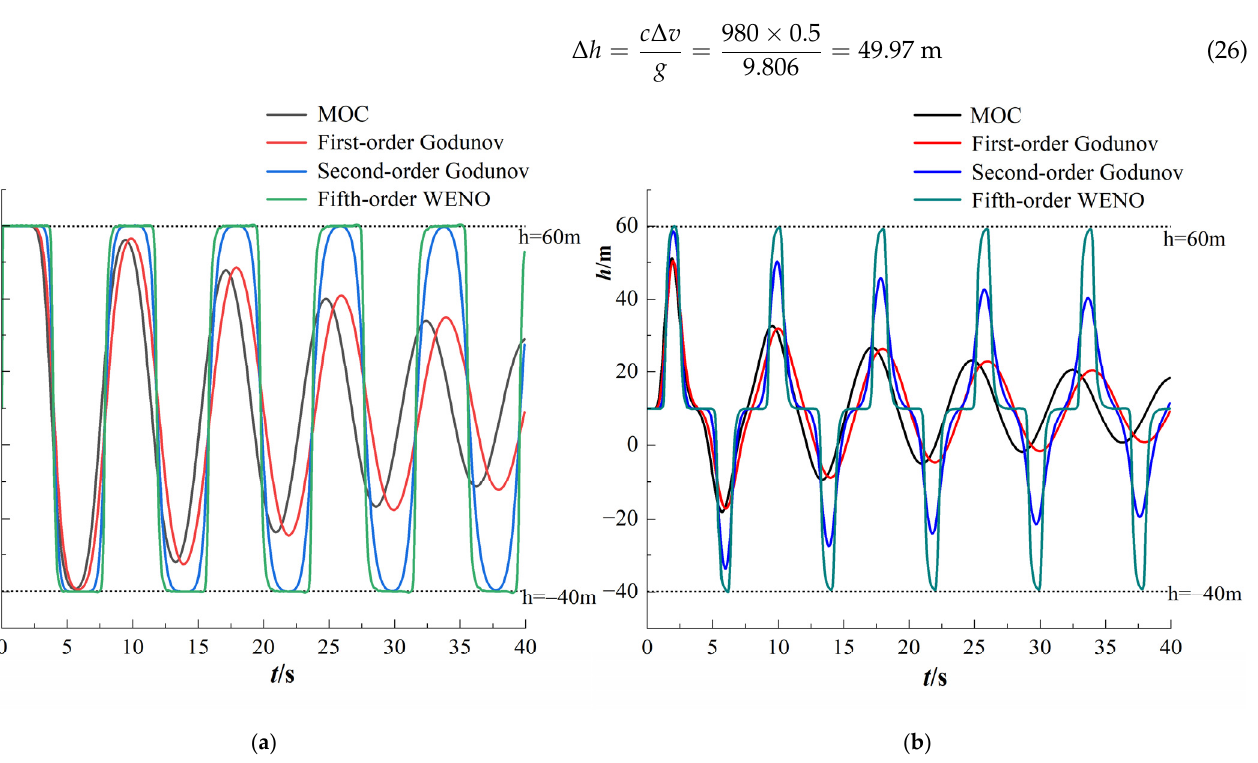
( b ) Figure 6. Comparison of results of different schemes for Cr = 0.01. ( a ) Comparison of pressure wave curve at value. ( b ) Comparison of pressure wave curves at 10 km 5.2. Model Application and GPU Acceleration Performance Evaluation The idealized long-distance water pipeline network shown in Figure 7 is constructed to evaluate the simulation’s computational accuracy and the GPU program’s acceleration effect. It is assumed that all the pipelines are long-distance transmission pipes of several tens of kilometers, and points A and B are the branch points of the trig point. The relative